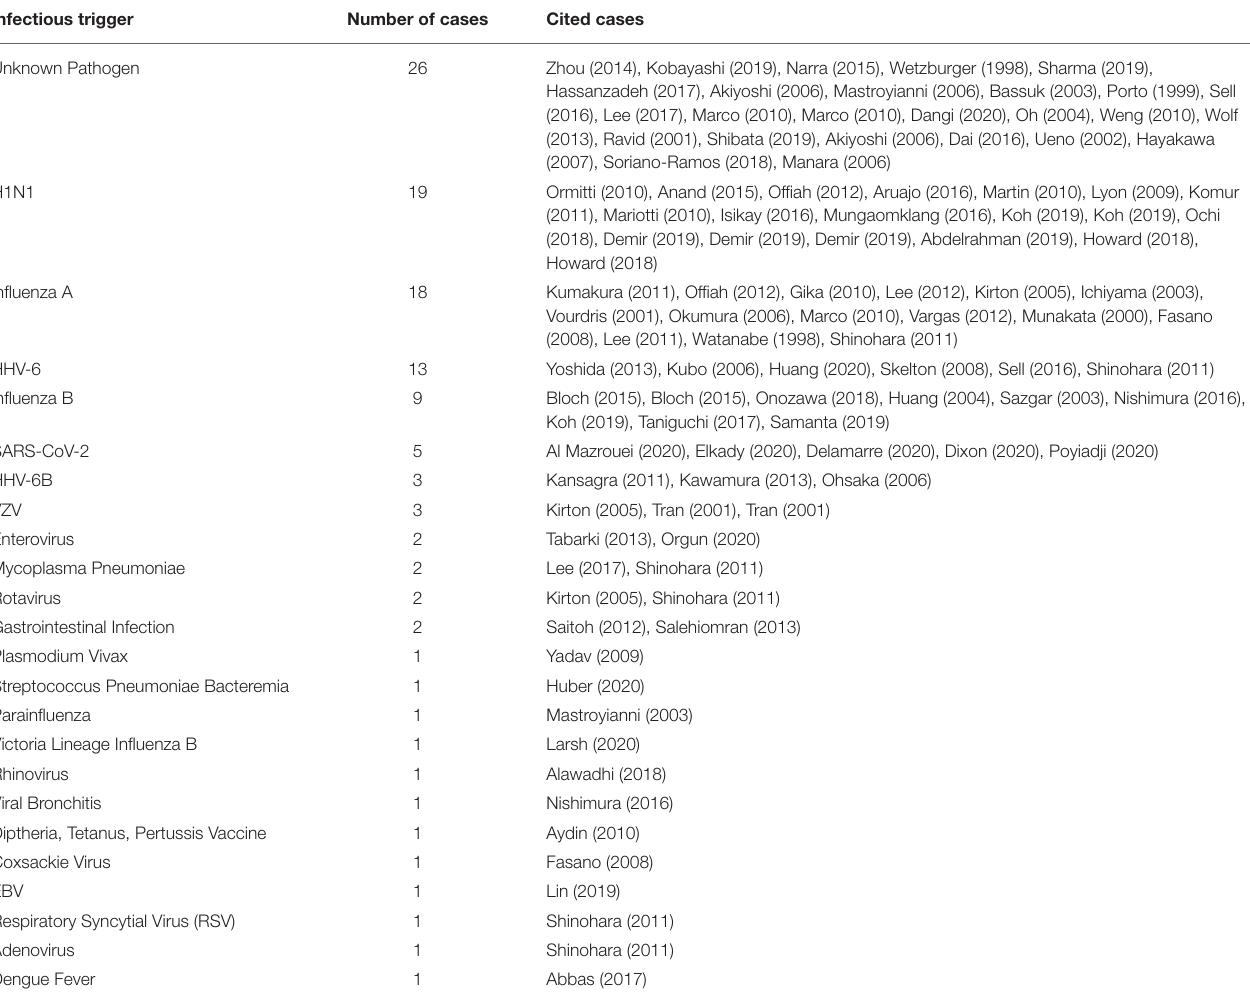
TABLE 1 | Infections associated with ANE. Infectious trigger Number of